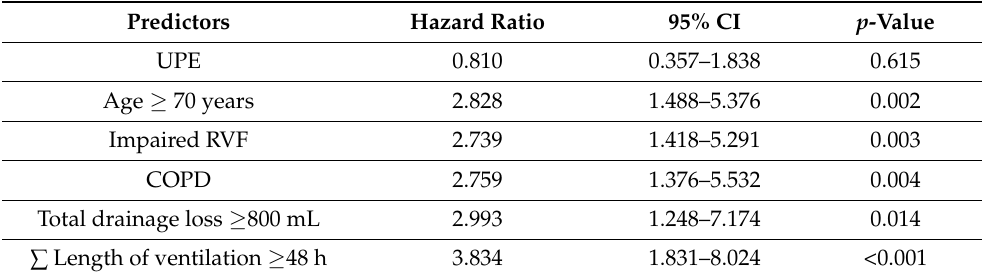
Table 5. Cox regression analysis for long-term mortality risk factors after